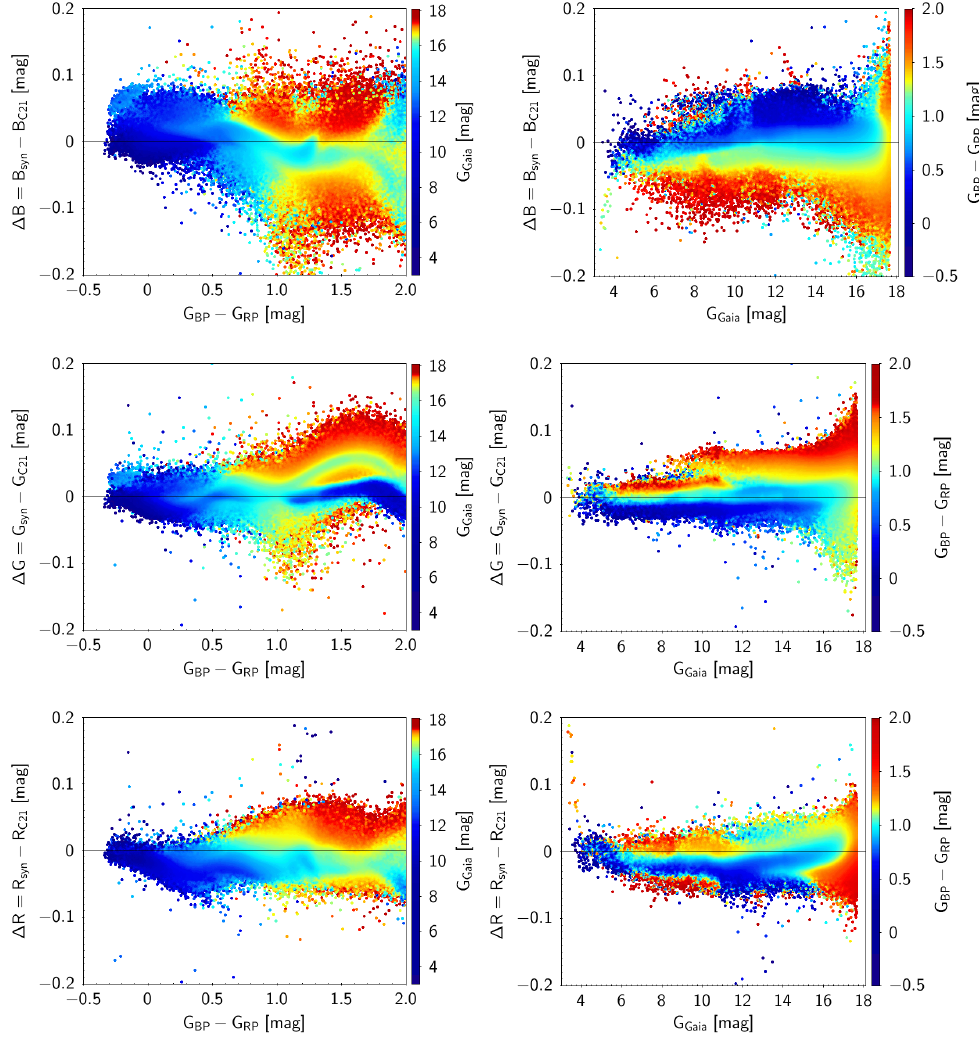
Figure 9. Difference between the synthetic magnitude computed in this work ( X syn ) and those provided by C21 ( X C 21 ) for X = B RGB ( top row ), G RGB ( middle row ) and R RGB ( bottom row ) as a function of Gaia G BP − G RP colour ( left column ) and G Gaia magnitude ( right column ) for non-variable sources in